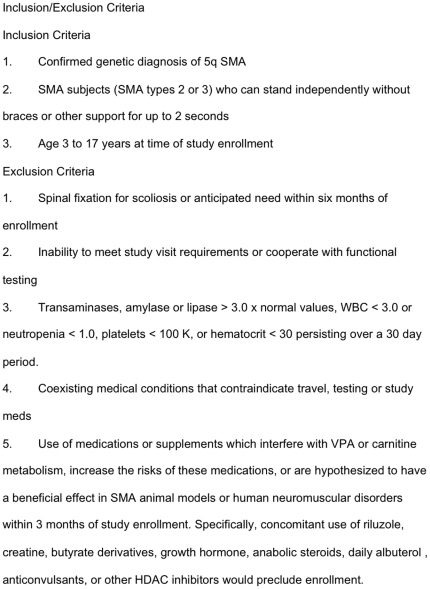
Inclusion/exclusion criteria for study enrollment.